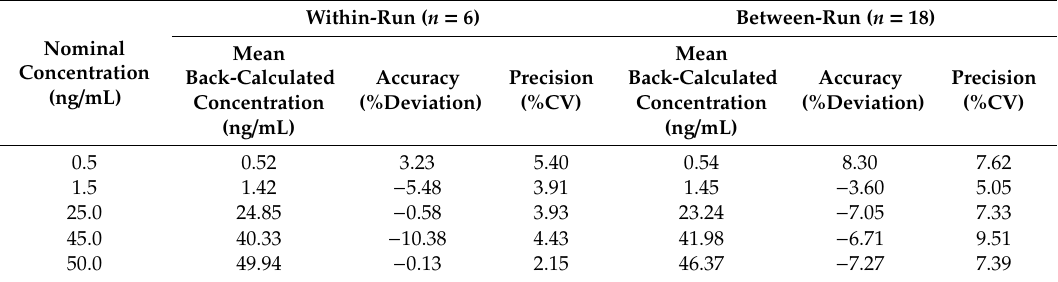
Table 2. Within-run and between-run accuracy and precision of sumatriptan